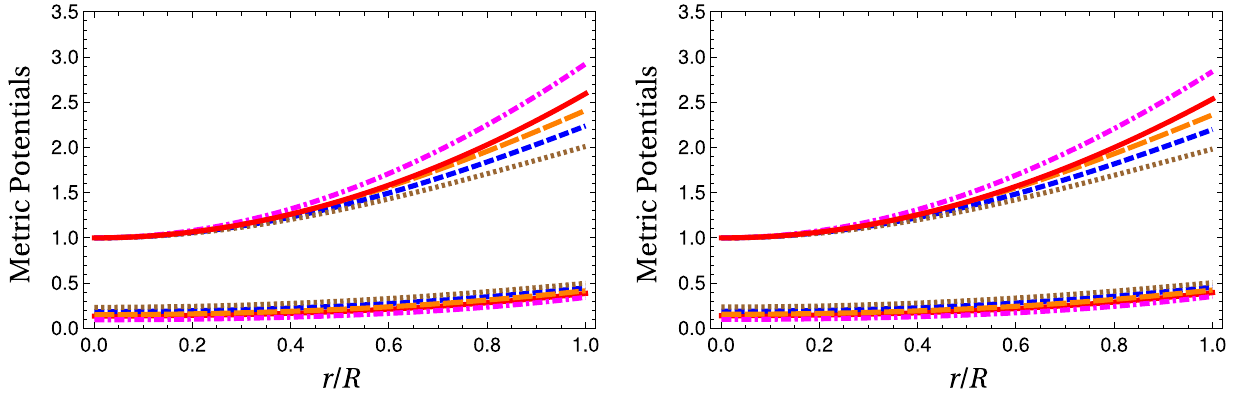
Fig. 1 Metric potentials e ν and e λ vs dimensionless radial coordinate r / R for the five plus five interior solutions obtained here, see Tables 1 and 2 for the initial conditions, and Tables 3 and 4 for the prop- erties of the stars. They exhibit the usual behaviour of interior solu- tions of relativistic stars, i.e. they are increasing functions of r , and e ν always remains below e λ . Since m ( r = 0 ) = 0, the metric potential e λ